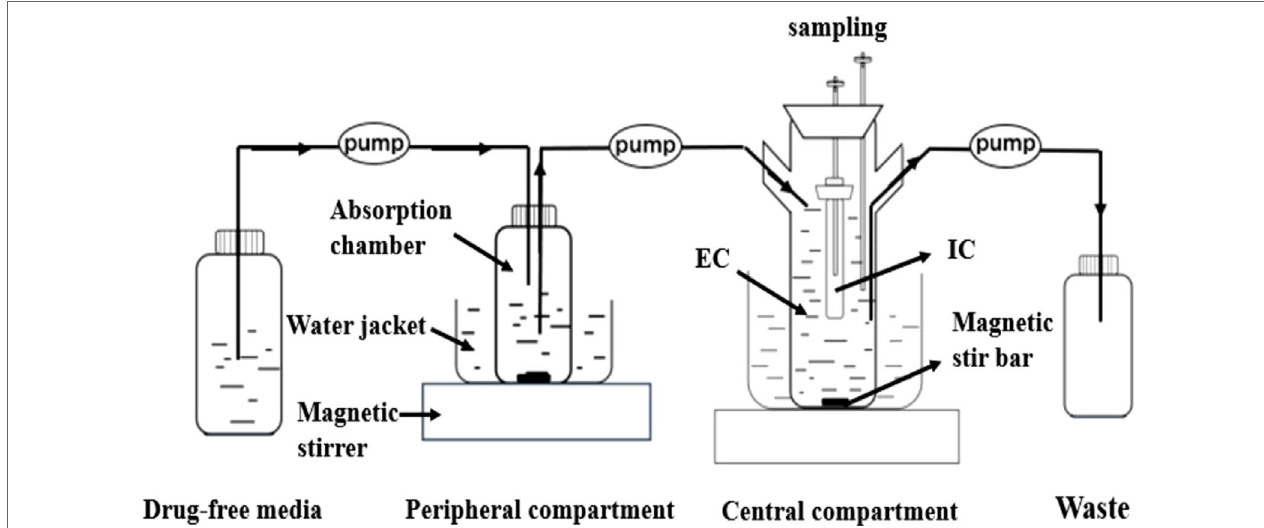
FIGURE 1 | The in vitro model that simulates the pharmacokinetics of tilmicosin in lung tissues of the Mycoplasma gallisepticum -infected chickens and determines a drug’s effect on the growth and susceptibility of M. gallisepticum. EC, external compartment; IC, internal